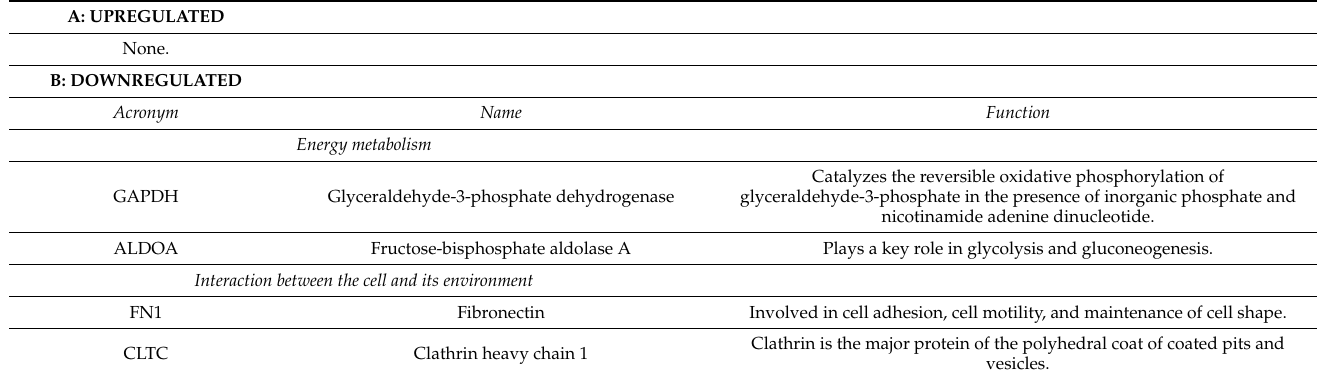
Table 7. Proteins which expression was altered between H24 and